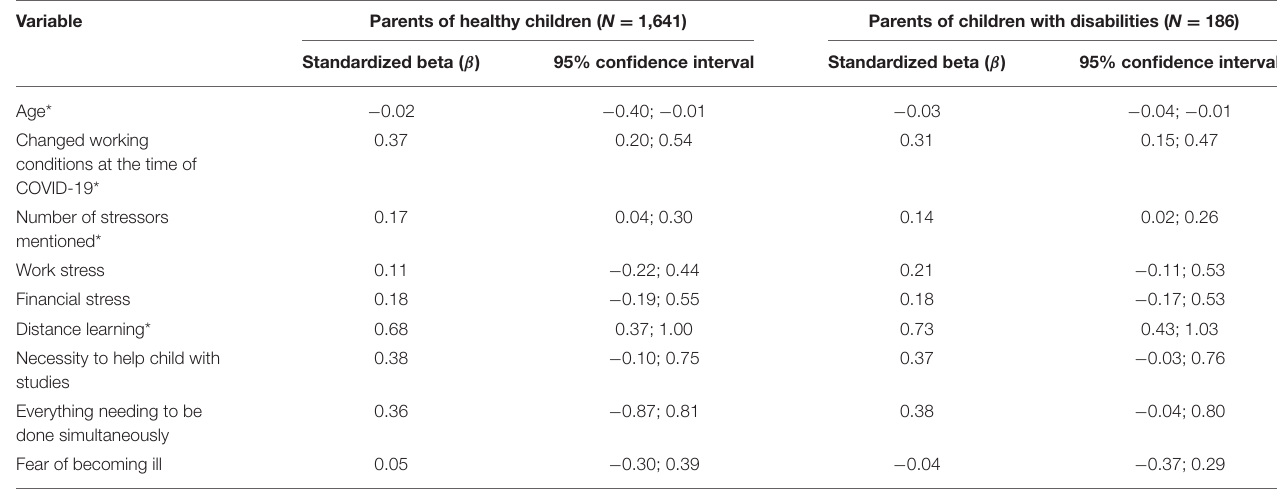
TABLE 3 | Differences in stress levels before and during COVID-19 pandemic emergency situation in May-June 2020, demographic parameters and stressors between parents with and without children with developmental disorders or chronic conditions—results of linear regression models.